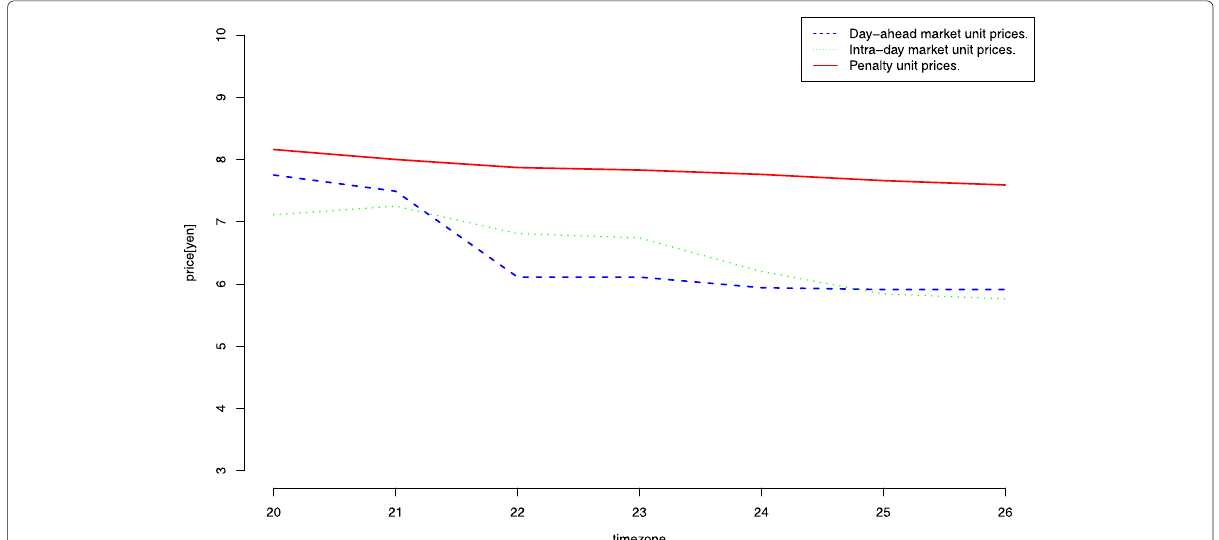
Fig. 6 Unit prices ( d = 1). This figure is a line chart of the day-ahead market unit prices, the intra-day market unit prices, and the penalty unit prices when d =